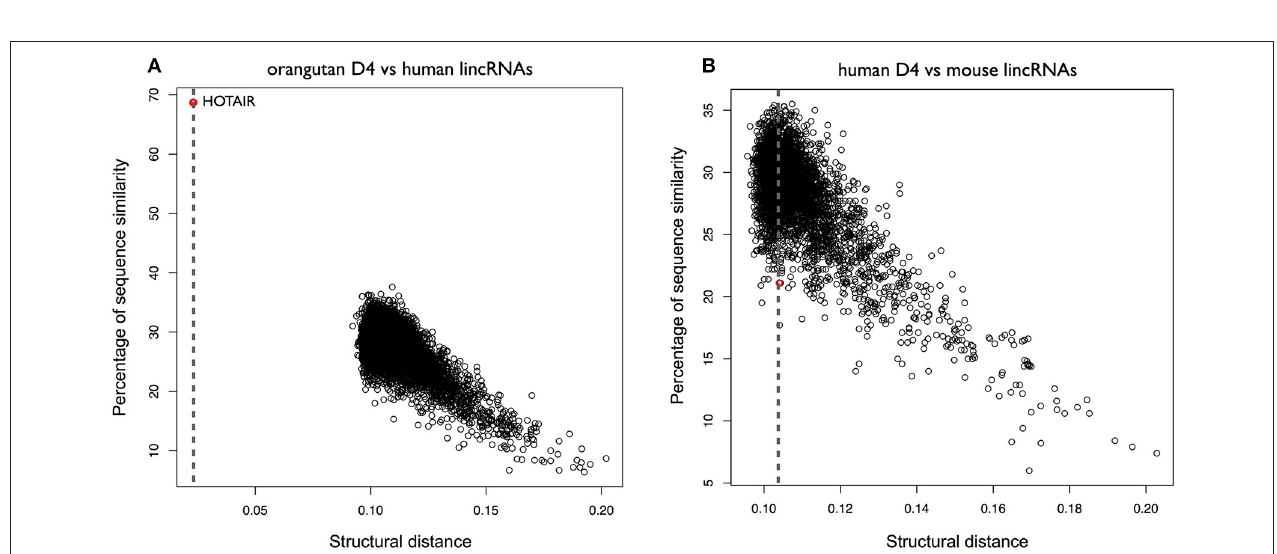
FIGURE 7 | Structural conservation of HOTAIR D4 in different species. (A) Structural similarities of Orangutan D4 against all human lincRNAs. The distance was obtained using OBE-DTW and plotted against sequence similarity. Human D4 is identified as the best match (colored in red). (B) Structural similarities of human against all mouse lincRNAs. Human D4 is not identified as the best match (1849th best hit; colored in